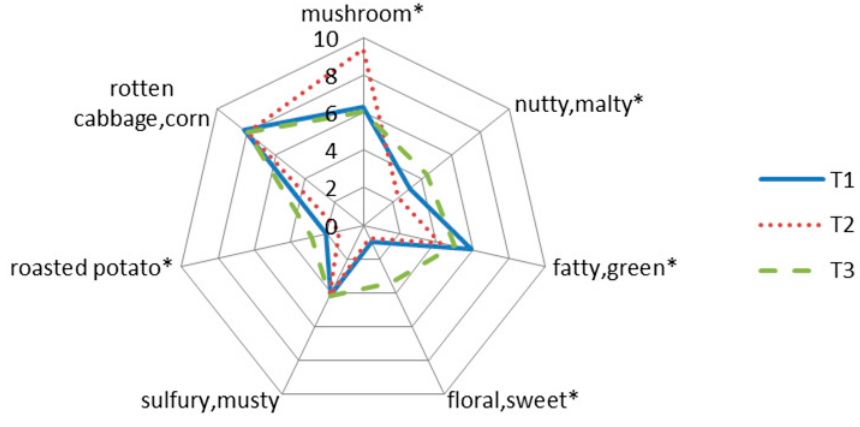
Figure 1. The aroma profiles of tru ffl e samples obtained from T1, T2 and T3 samples. The seven notes with “*” are significantly di ff erent between samples ( p < 0.05). Table 4. The mean intensity values of the seven attributes for the three truffles in descriptive sensory evaluation.